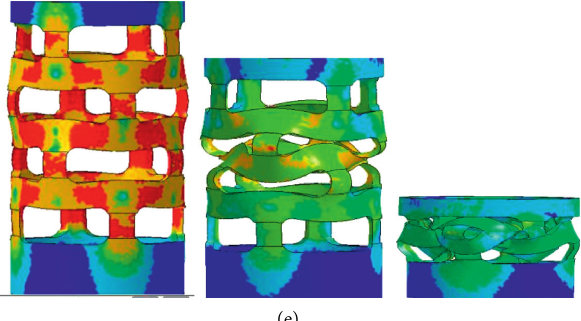
Figure 4: Compression and the buckling deformation process of each scheme member. (a) Buckling deformation process of YG-1, (b) buckling deformation process of YG-2, (c) buckling deformation process of YG-3, (d) buckling deformation process of YG-4, and (e) buckling deformation process of YG-5.